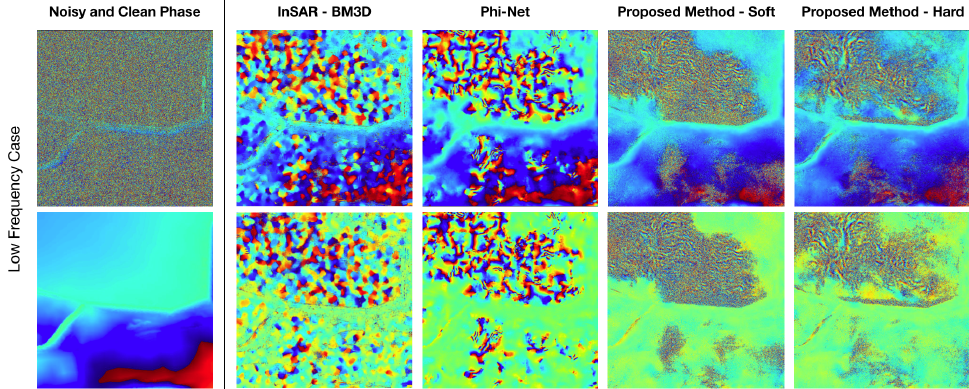
Figure 9. Filtered interferometric phase ( top ) and corresponding residues ( bottom ) of the three compared methods tested on low-frequency synthetic data.